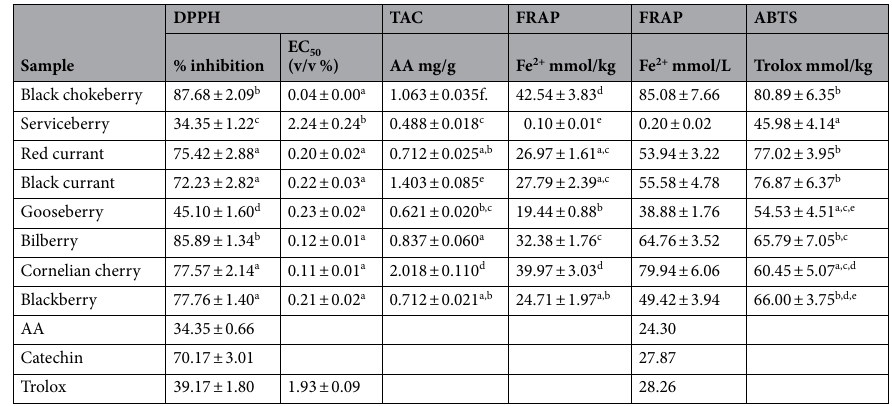
Table 2. Antioxidant activity of samples determined by DPPH, TAC, FRAP, and ABTS assays (all results expressed on wet weight). AA-ascorbic acid; Means not sharing the same letter in the same column are significantly different at p < 0.05 probability. Concentrations for standards AA, catechin and Trolox were 50 μmol/L.